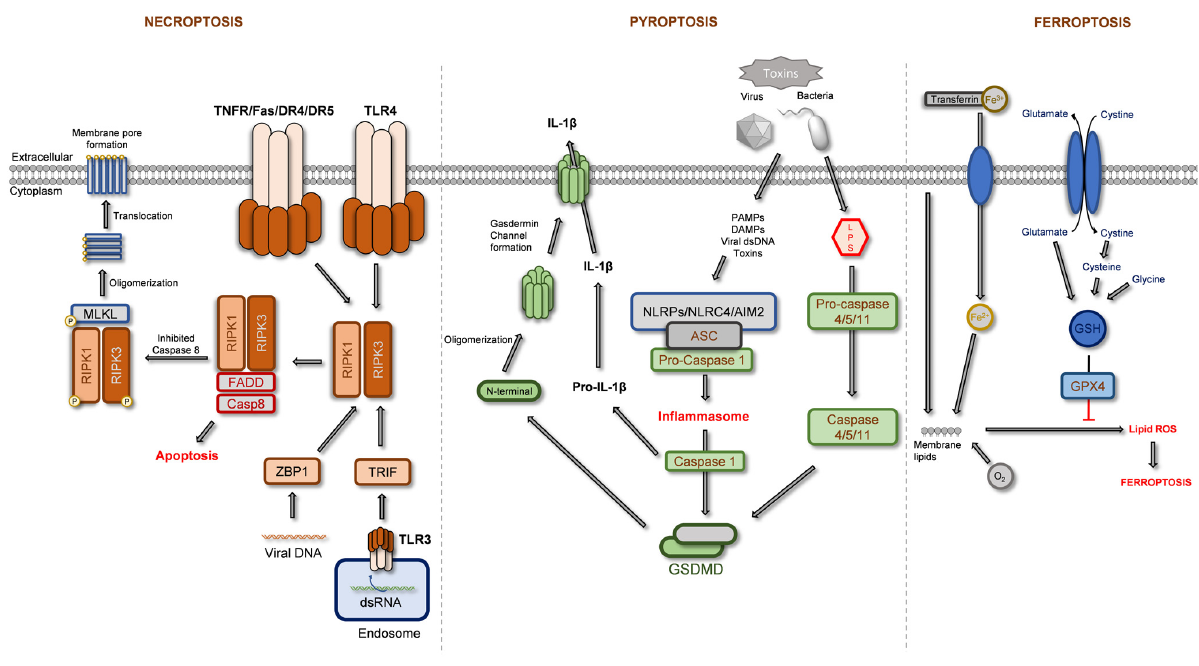
Figure 1. Schematization of signaling pathways of regulated forms of necrosis: necroptosis, pyroptosis, and ferroptosis. Adapted from [20–30], and from illustrations courtesy of Cell Signaling Tech- nology [31] , Inc.. The red arrow means inhibition; the grey arrow means inducer. Abbreviations: AIM2, Interferon-inducible protein AIM2; ASC, apoptosis-associated speck-like protein containing a CARD; Casp8, caspase-8; DAMPs, damage-associated molecular patterns; FADD, Fas-associated death domain; IL-1 β , interleukin 1 β , LPS, lipopolysaccharide; NLRC4, NLR family CARD domain- containing protein 4; NLRPs, NLR family pyrin domain containing; PAMPs, pathogen-associated molecular patterns; TRIF, TIR-domain-containing adapter-inducing interferon- β ; All other abbrevi- ations are mentioned in the text. 2.1.1. Necroptosis Necroptosis presents morphological hallmarks typical of necrotic death: no chroma- tin condensation, swelling, and rounding of the cell and dilated organelles; but just as other regulated cell death types, this is driven by signaling pathways. Necroptosis has already been correlated with chemotherapy drugs-induced cytotoxicity, and identified in pathologies such as myocardial infarction psoriasis, cirrhosis, pancreatitis, neurodegener- ative diseases, or ischemic injury [17,20]. This pathway is highly dependent on RIPK1 (re- ceptor-interacting serine/threonine-protein kinase 1) and RIPK3 (receptor-interacting ser- ine/threonine-protein kinase 3), which have been used as markers of necroptosis [17]. Considering the signaling pathway, necroptosis signaling is mediated through stim- uli induced in tool-like receptors 3 and 4 (TLR3/TLR4), tumor necrosis factor receptor 1 (TNFR1), Fas receptor (also called Fas, CD95 or apoptosis antigen 1), death receptors 4 and 5 (DR4/DR5) or Z-DNA-binding protein-1 (ZBP1) [19,20]. In this last one, the stimuli originated from nucleic acids of pathogens, such as a virus. For all the receptors mentioned above, RIPK3 recruitment is required, while RIPK1 recruitment is required for Fas, TNFR1, and DR4/5, where it binds to RIPK3. Upon this stage, RIPK3 is phosphorylated, to form the necrosome, which then activates MLKL (mixed lineage kinase domain-like pseudokinase), which triggers a change in confor- mation and migration to the cell membrane, inducing membrane permeabilization, leak- age of intracellular content and inflammation [19,20]. Being a regulated process, necrop- tosis maintains a strict connection with apoptosis and cell proliferation. Caspase-8, for example, is a regulator of necroptosis. When increased, the apoptotic pathway is favored,